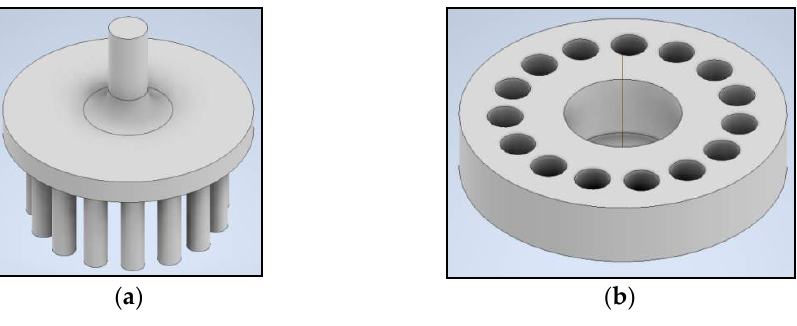
Figure 7. Designed components: cap ( a ); knob ( b ).